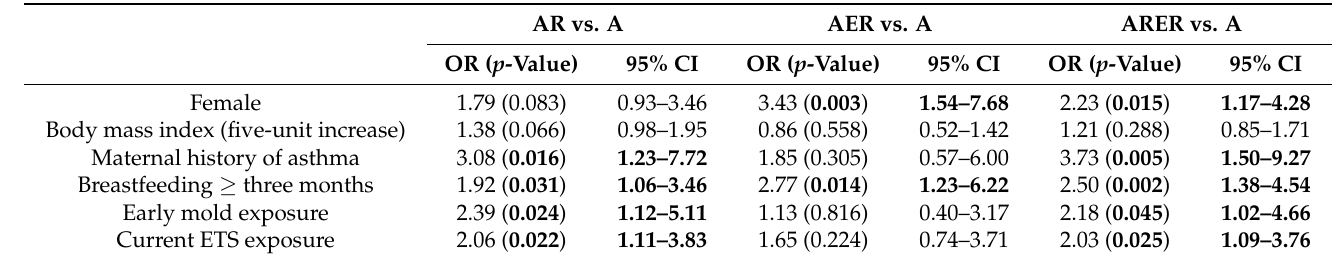
Table 3. Estimated odds ratios (OR), p -values and 95% confidence intervals (CI) from the multinomial logistic regression